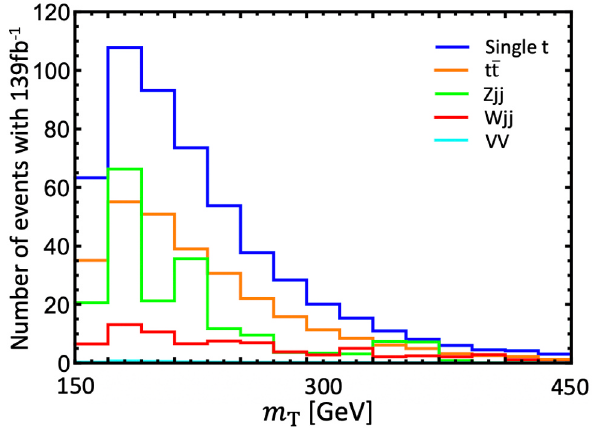
Figure 2 . Expected SM BG m T distributions after applying all kinematic cuts, shown as number of events per m T bin. We assumed 139 fb − 1 of data. The colors distinguish the different BG categories, as detailed in the upper right corner.